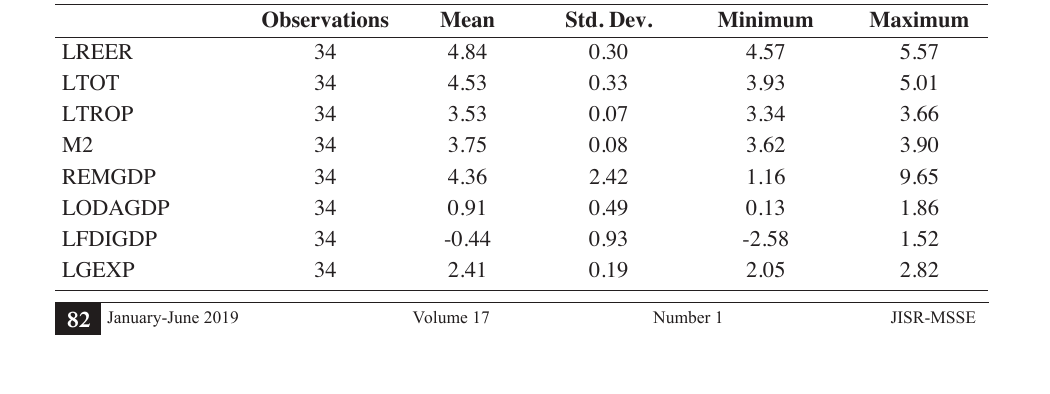
Table 1a : Summary